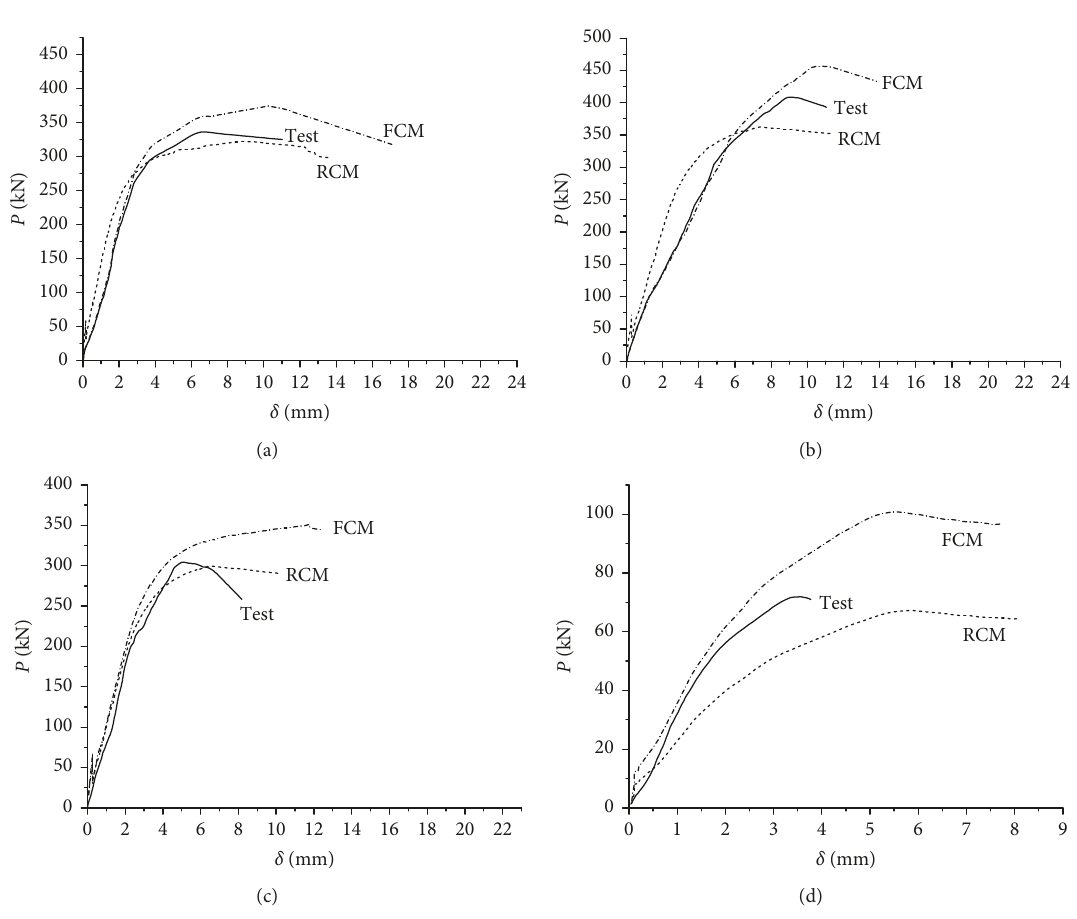
Figure 9: Comparison of experimental load-displacement curve to that of FEM: (a) SCS-1, (b) SCS-2, (c) SCS-3, and (d) SCS-4.